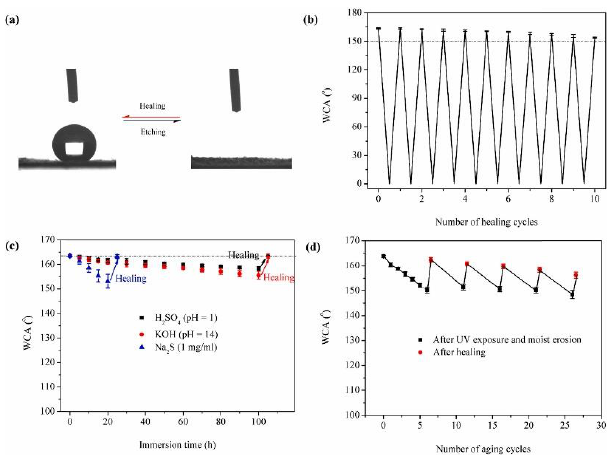
Figure 5. Wettability change of hybrid cotton fabric after oxygen plasma etching and the following self-repairing ( a ) with the number of O 2 plasma etching ( b ), chemical treatment time ( c ), and UV aging and moist erosion cycles ( d ). Reprinted from Colloids Surf. A Physicochem. Eng. Asp. 2021, 6305 , Li, H.; Miao, S.; Chen, W.; Yang, X.; Li, M.; Xing, T.; Zhao, Y.; Chen, G., Durable superhydrophobic and oleophobic cotton fabric based on the grafting of fluorinated POSS through silane coupling and thiol-ene click reaction, 127566. [69] Copyright (2021), with permission from Elsevier.